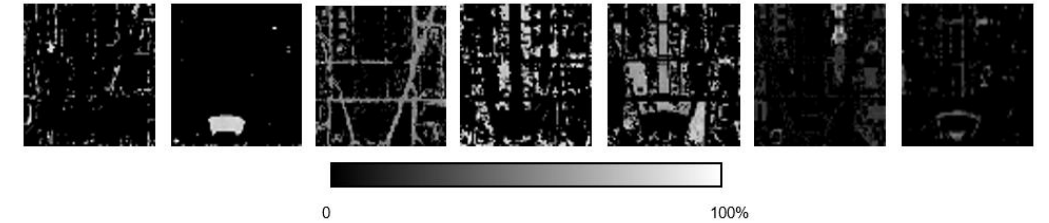
Figure 7. Proportion images of the seven classes obtained by spectral unmixing of the Data set 2: From left to right: shadow, water, road, tree, grass, roof, and trail.